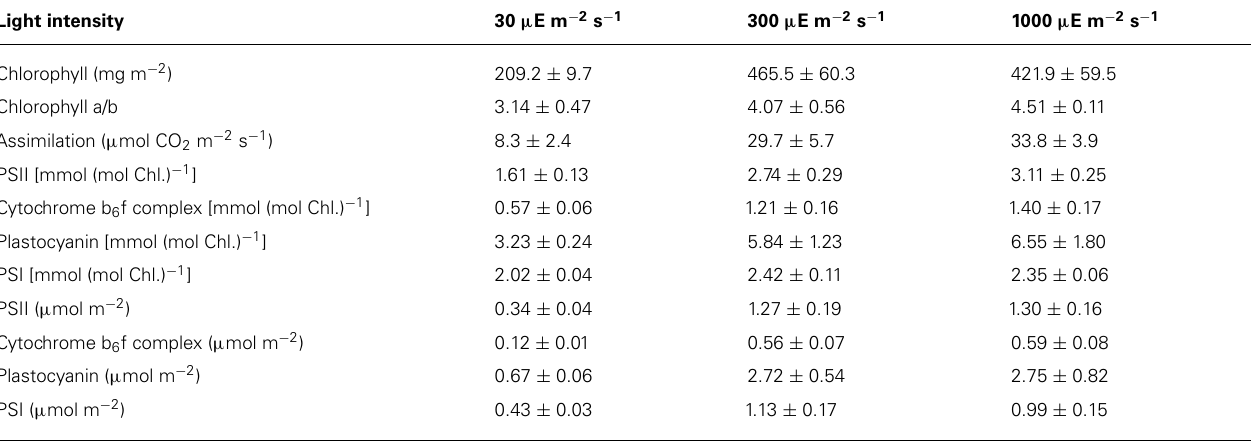
Table 2 |Acclimation of the photosynthetic apparatus of tobacco ( Nicotiana tabacum ) to increasing growth light intensities. Light